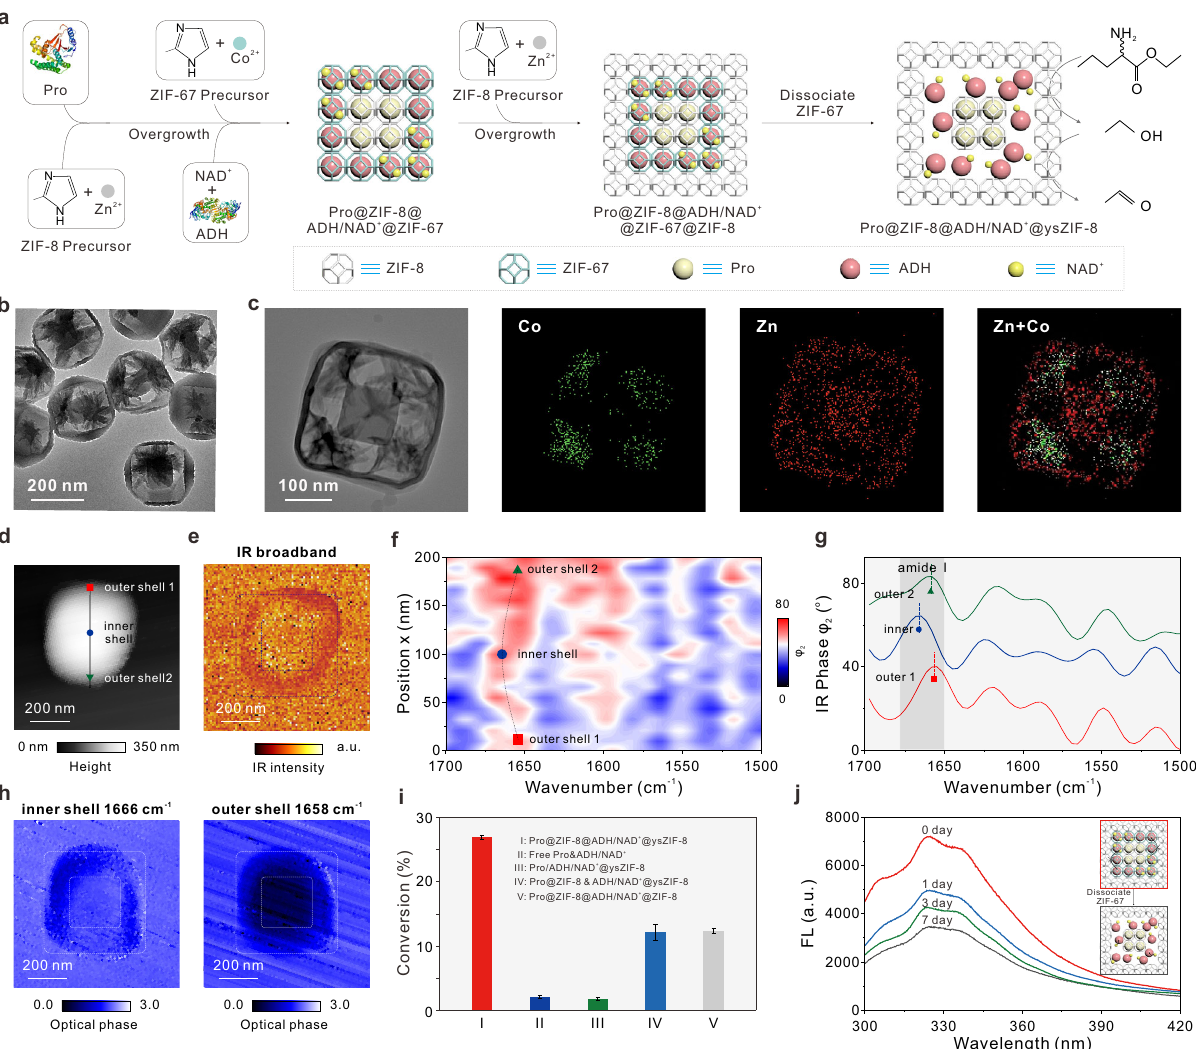
Fig. 2 Operation of Pro-ADH/NAD + cascade in multi-shelled hollow ZIF-8 MOFs. a Tandem biocatalytic reaction driven by incompatible enzymes and cofactor (Pro and ADH/NAD + ) encapsulated in multi-shelled hollow ZIF-8. b TEM, c STEM and EDX mapping images of as-synthesized Pro@ZIF- 8@ADH/NAD + @ysZIF-8. Nanoscale heterogeneity in Pro@ZIF-8@ADH/NAD + @ysZIF-8 by nano-FTIR analysis. simultaneously recorded d AFM topography image and e IR broadband image. f Nano-FTIR line scan along the solid arrow marked in panel d) with a step size of ~10 nm, and 20 spectra were recorded. g Representative nano-FTIR point spectra of the inner shell (inner) and outer shell (outer 1 and outer 2) of the particle, marked by respective colored symbols. Infrared phase images were recorded at h inner-shell 1666 cm − 1 and outer-shell 1658 cm − 1 of an individual particle. i Catalytic ef fi ciencies in Pro@ZIF-8@ADH/NAD + @ysZIF-8, free Pro & ADH/NAD + , Pro/ADH/NAD + @ysZIF-8, Pro@ZIF-8 & ADH/NAD + @ ysZIF-8, and Pro@ZIF-8@ADH/NAD + @ZIF-8 systems. j ADH emission spectrum in Pro@ZIF-8@ADH/NAD + @ZIF-67@ZIF-8 with different etching time of 0 day, 1 day, 3 day, 7 day (excitation wavelength: 280 nm, the diagram is the schematic illustration of association/dissociation of ADH/NAD + cofactors encapsulated in solid and hollow MOFs). In all experiments, the concentrations of Pro, ADH, and NAD + used were 5.35, 19.3, and 17.1 μ g mL − 1 . The error bars represent standard deviation based on three